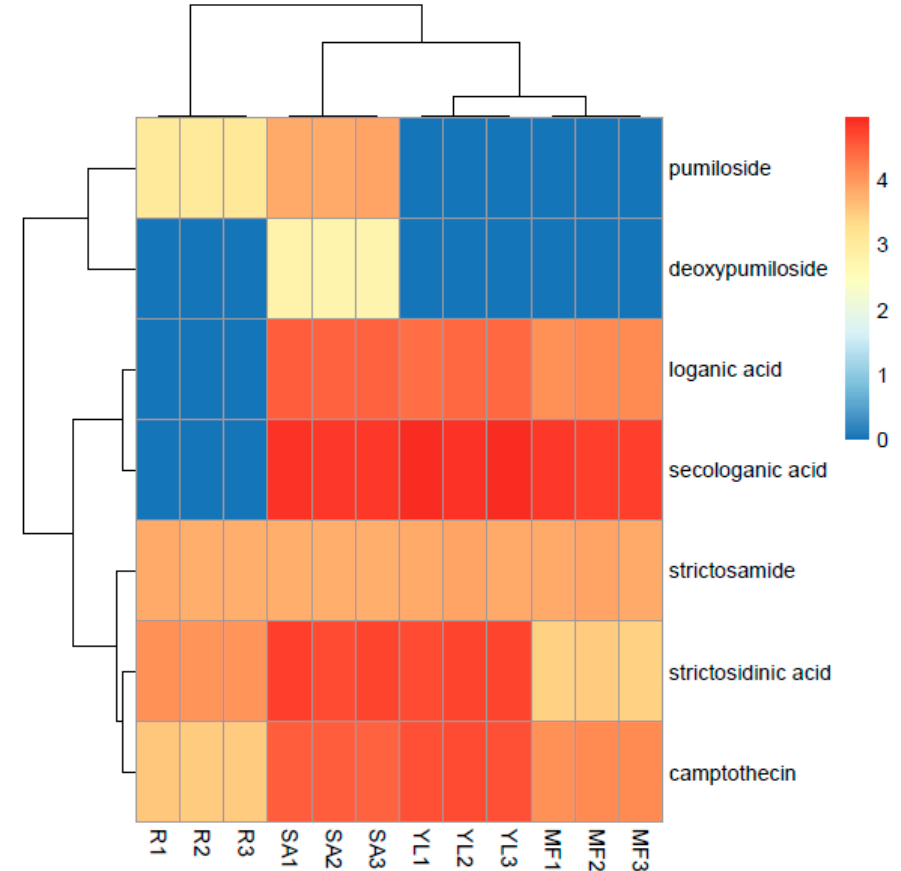
Figure 3. Comparative analysis of intermediate metabolite content in different plant parts after MAE by heat map using raw peak response of HPLC-TSQ-MS. R1–R3: root 1–3; SA1–SA3: shoot apex 1–3; YL1–YL3: young leaf 1–3; ML1–3: mature leaf 1–3.